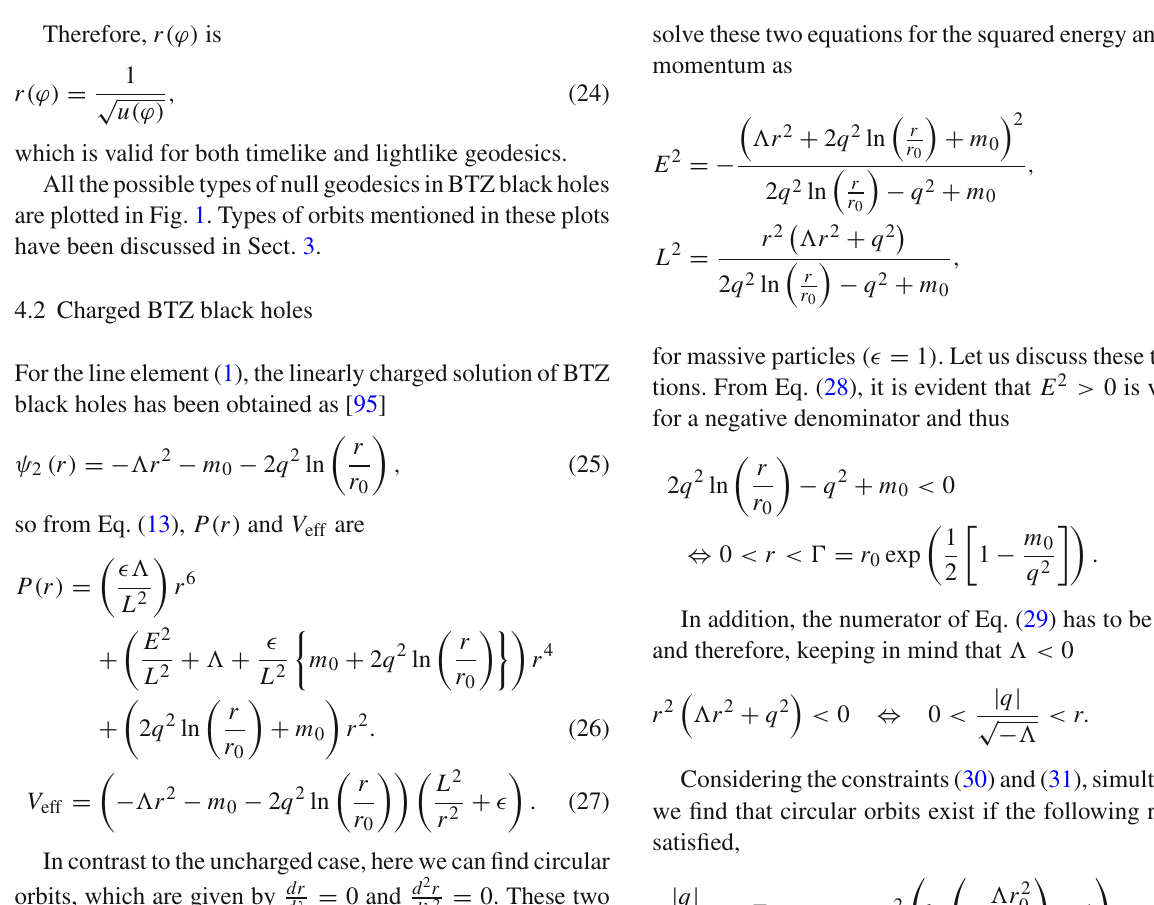
( a ) Terminating bound orbit in region (1) with E 2 = 4 (b) Terminating escape orbit in region (0) with E 2 = 6 and L − 2 = 0 . 018 and L − 2 = 0 . 018 Fig. 1 Null geodesics for the uncharged BTZ black hole with (cid:4) = − 0 . 1 and m 0 = 2. The dash dotted line represents the